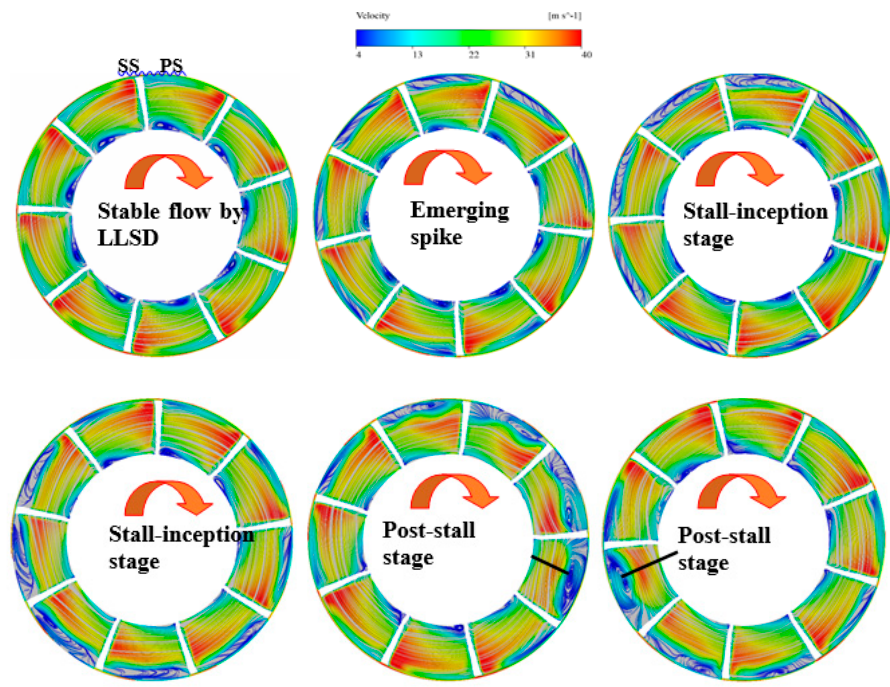
Figure 18. Transient flow characteristics in the middle section of rotor.